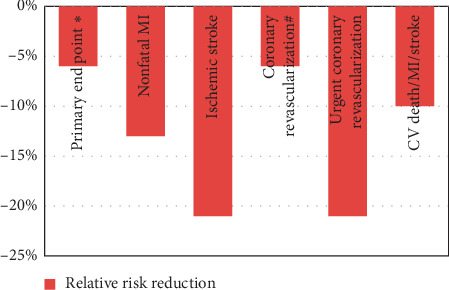
Clinical benefits achieved in the IMPROVE-IT trial (∗primary end point was a combination of CV death/major CV event and nonfatal stroke; #nonsignificant. There was no difference in CV death and unstable angina).